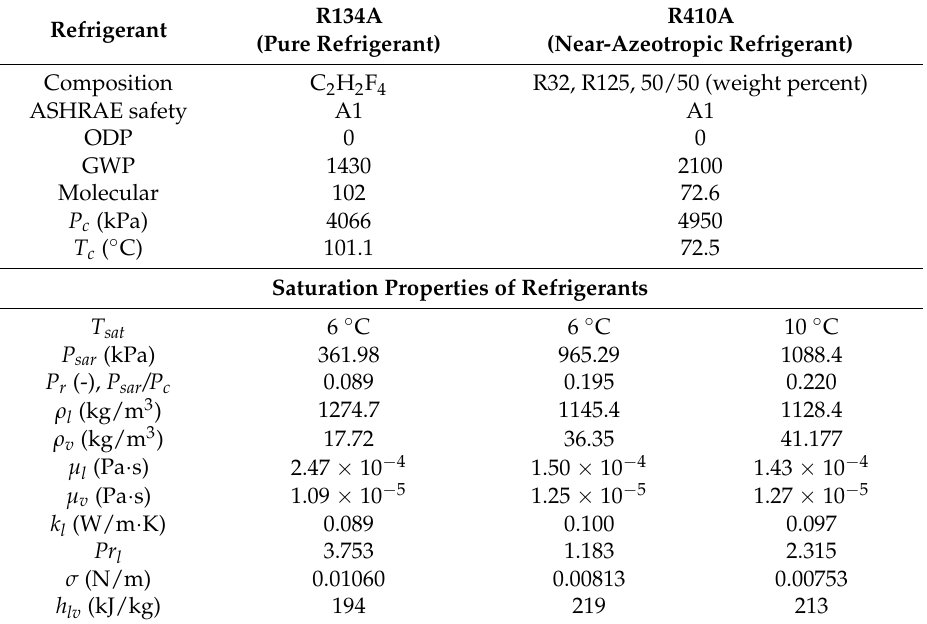
Table 1. Thermophysical and environment properties of refrigerants R134A and